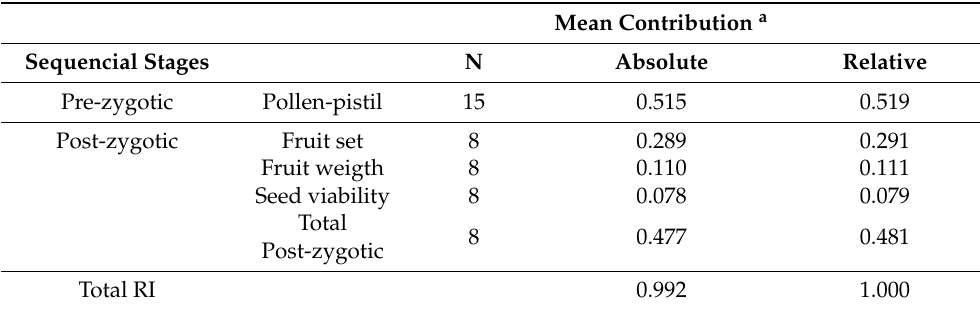
Table 1. Absolute and relative mean contribution to RI of sequential pre- and post-zygotic isolation stages in Cucumis